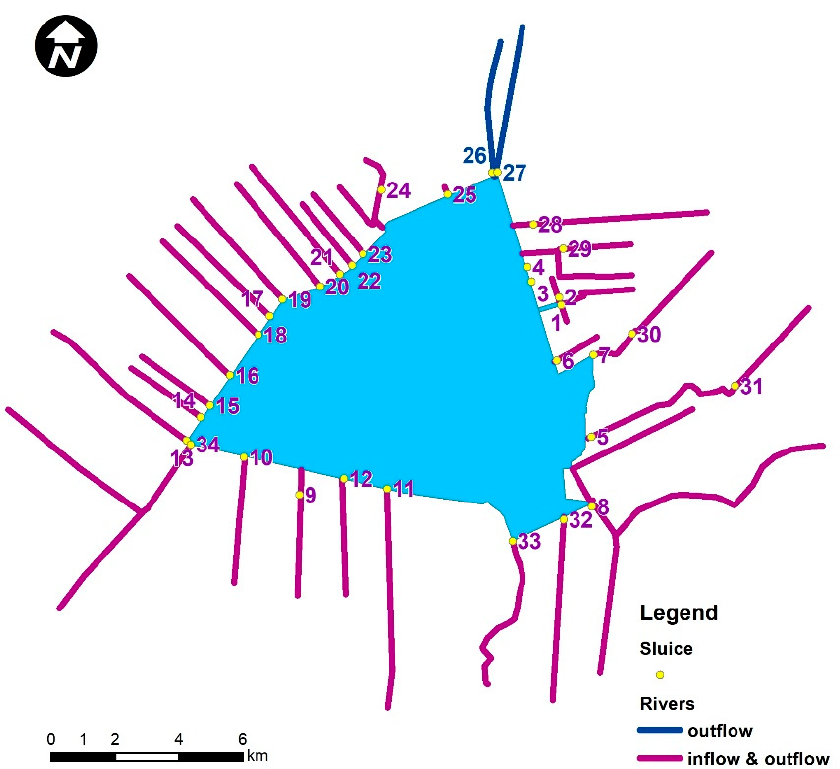
Figure 3. Map of the rivers entering (sampling sited denoted by yellow dots) Lake Datong (through electric gates), as well as the outflow (violet) and bidirectional flow (navy blue). The bidirectional flow of the river indicates that precipitation depends on the alternating in- and outflow of river water.